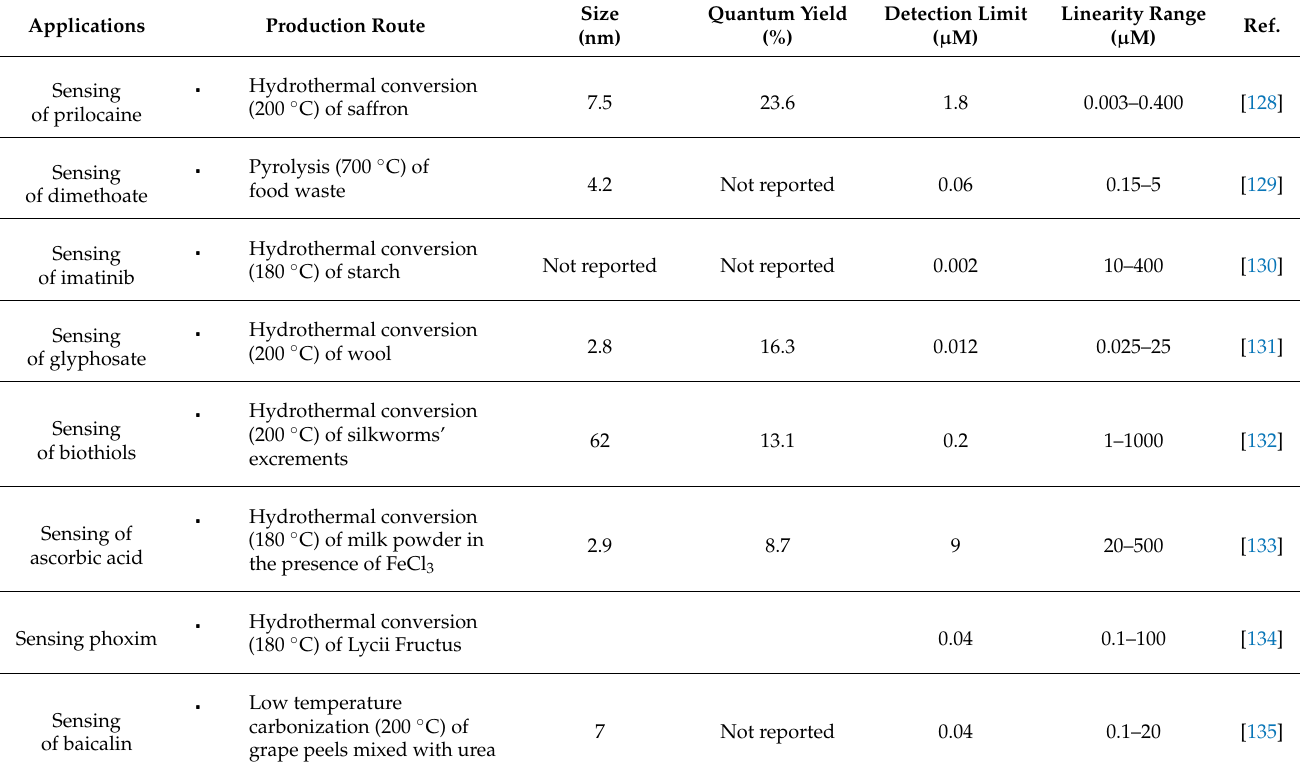
Table 2. Summary of the main study on organic detection by using BCCDs